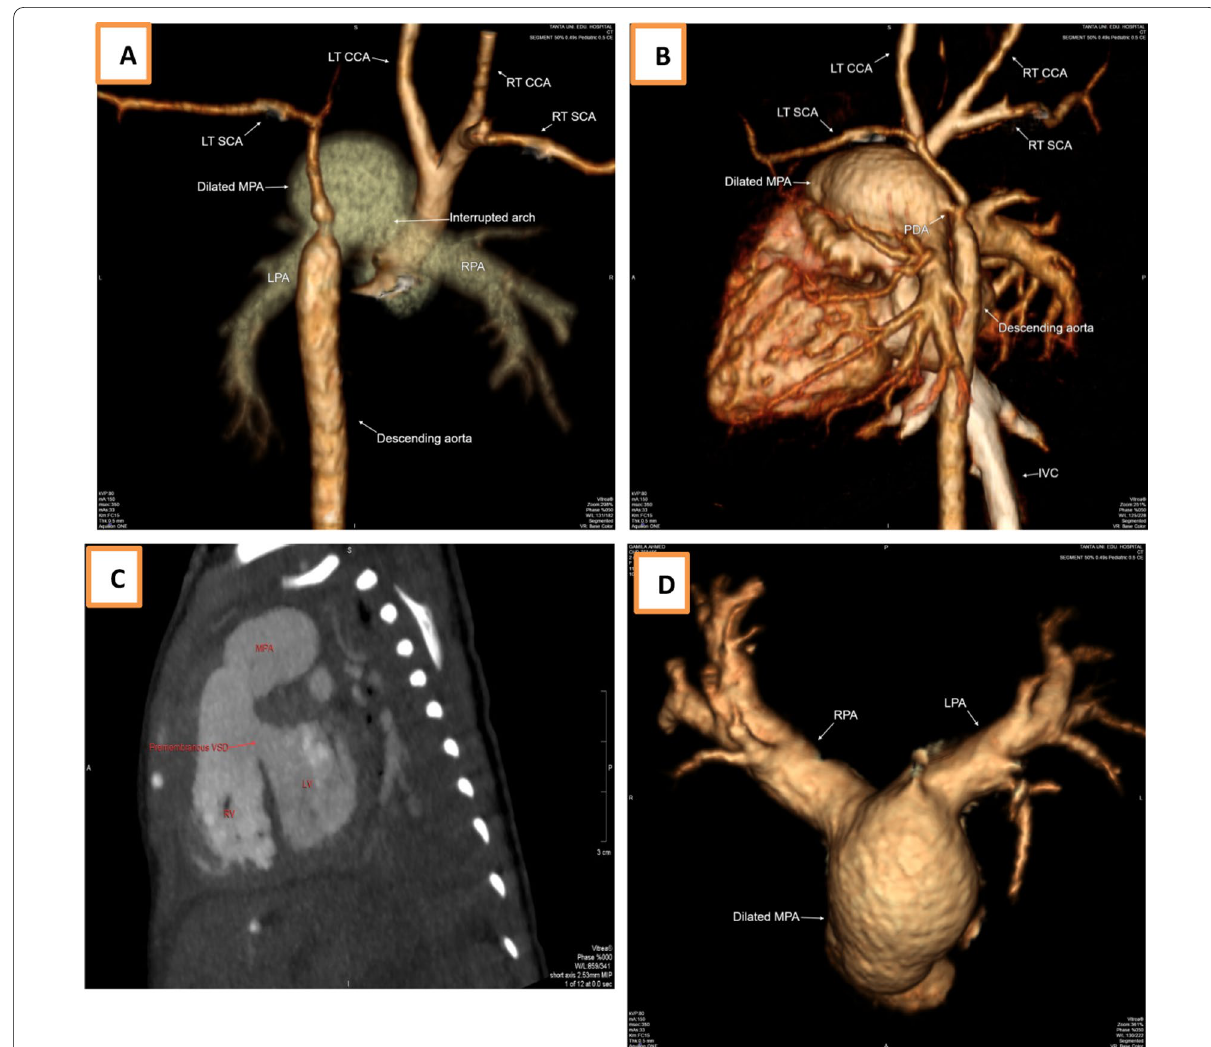
Fig. 5 : A 2‑day‑old female patient presented with cyanosis and poor feeding. a MDCT VR posterior view showed interrupted aortic arch proximal to left SCA, b VR oblique posterior view showed PDA connecting aortic isthmus to LPA, c Short axis MIP view of the heart showed perimembranous VSD, d VR image showed dilated MPA, LPA and RPA. A case of interrupted aortic arch with duct dependent systemic circulation